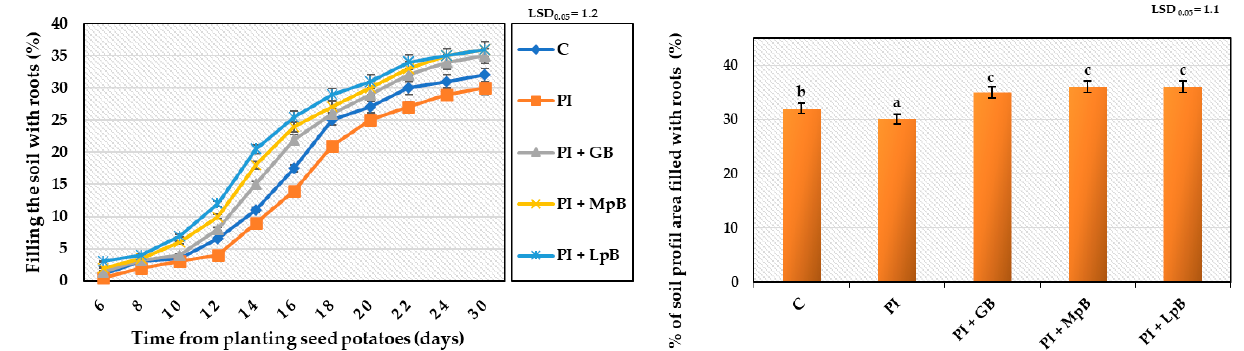
Figure 2. Soil profile overgrown by developing root system obtained from seed potatoes: ( A ) in- fected with phytopathogens; ( B ) biologically treated and then infected with phytopathogens.